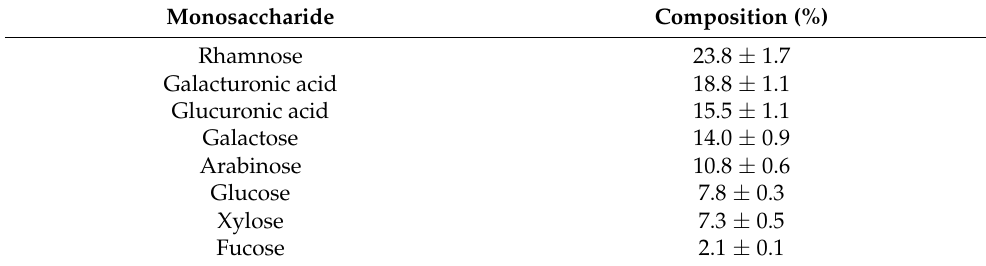
Table 2. Monosaccharide composition of the mucilage extracted from the Corchorus olitorius L.